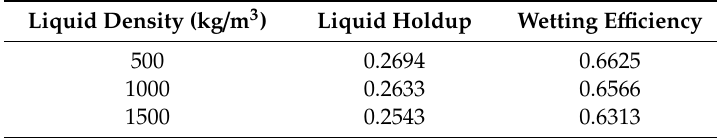
Table 8. Liquid holdup and wetting e ffi ciency of three liquid densities. Table 9. Liquid holdup and wetting efficiency at different liquid and gas velocities.